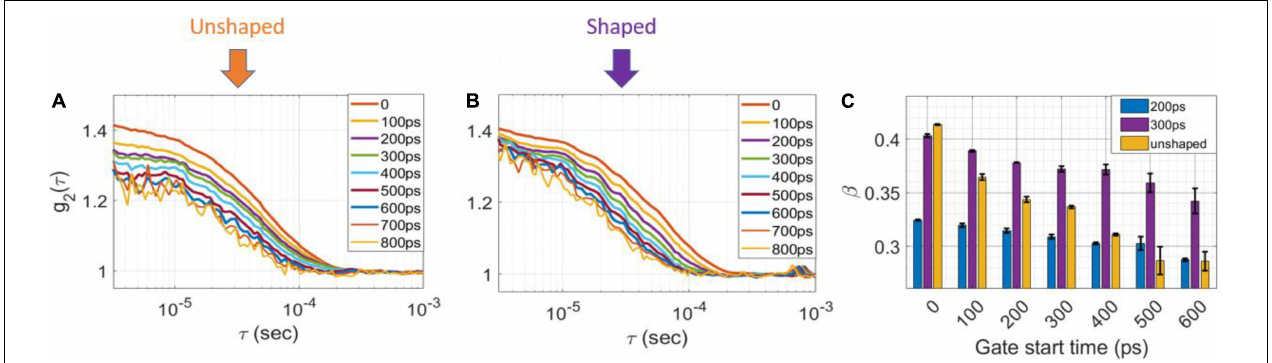
FIGURE 3 | Measurement results with shaped and unshaped pulses for homogenous phantoms. The intensity autocorrelation curves (g 2 ) of (A) unshaped and (B) 300 ps FWHM for the homogenous phantom at different gate start times, 200 ps gate width. (C) The coherence factor, β for 200 ps FWHM (blue), 300 FWHM (magenta) and unshaped (orange) pulses as a function of gate start time of homogenous phantom at 200 ps gate width.